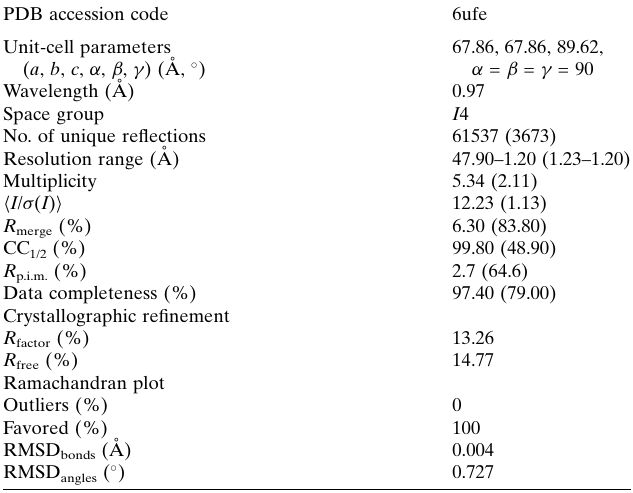
Table 2 Data and refinement statistics for our atomic resolution X-ray structure of the open form of NaK2K. The highest-resolution shell is shown in